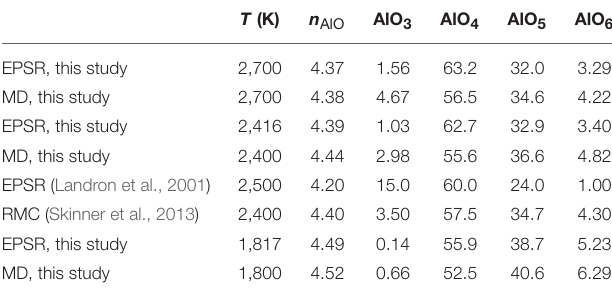
TABLE 2 | Summary of average Al-O coordination number and speciation (%) of liquid alumina obtained using r 2 = 2.5 Å.